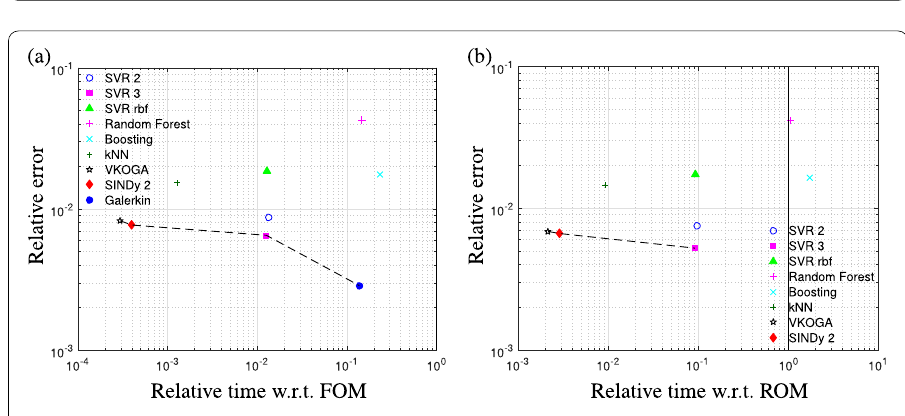
Fig. 10 Runge–Kutta for 2D convection–diffusion equation: time evolution of relative error: a e FOM ( t ) in FOM; and b e ROM ( t ) in ROM